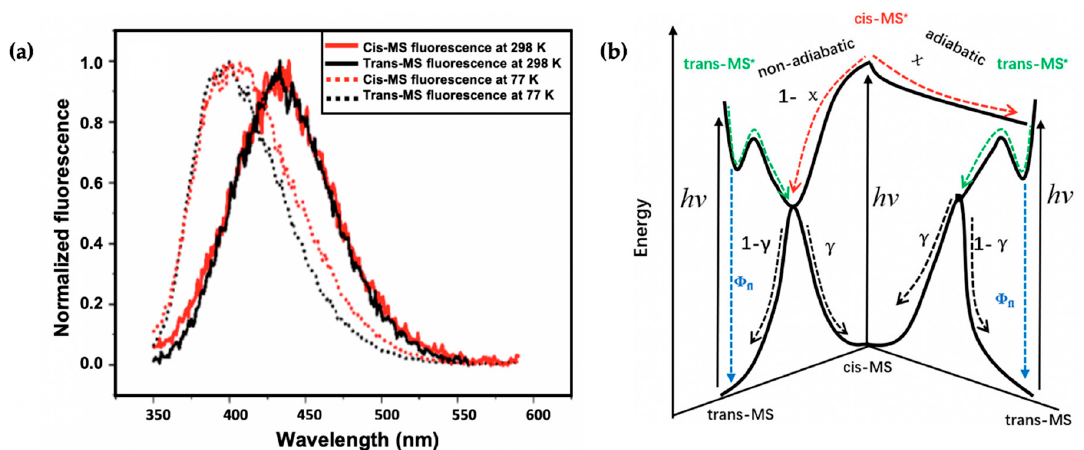
Figure 8. ( a ) Steady-state emission spectra of trans -MS (black solid line) and cis -MS (red solid line) at room temperature. The corresponding emission spectra at 77 K are shown as dotted lines. ( b ) Schematic of the proposed relaxation scheme of MS by Zhao et al. [113]. Reproduced and adapted with permission from [113]. © 2019 American Chemical